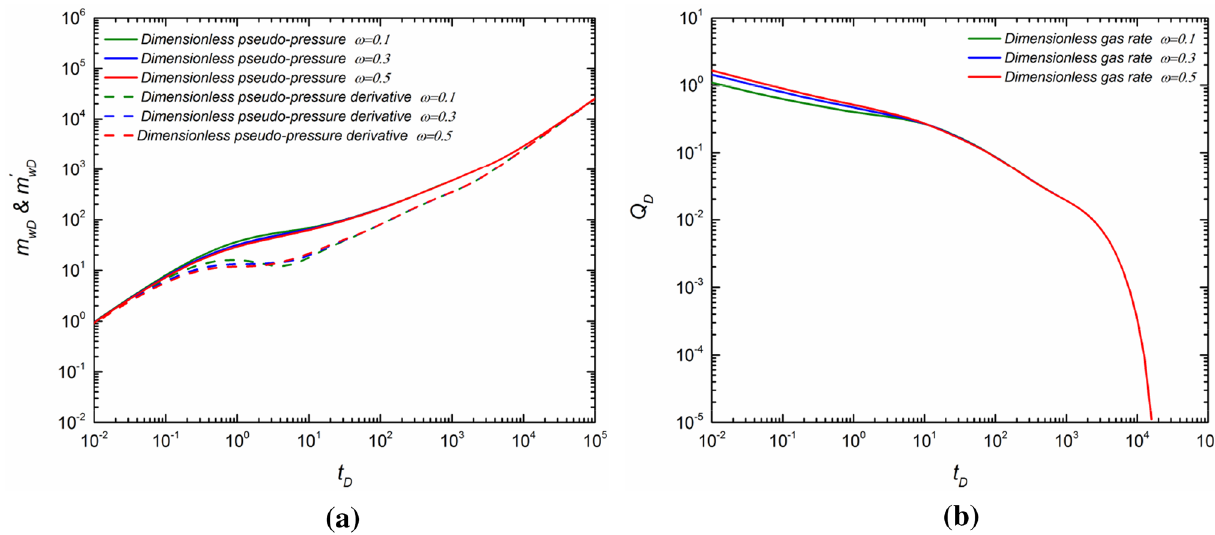
Fig. 7 Effect of storativity ratio on pseudo-pressure and rate curves. a Dimensionless pseudo-pressure and pseudo-pressure derivative curve, b dimensionless rate curve